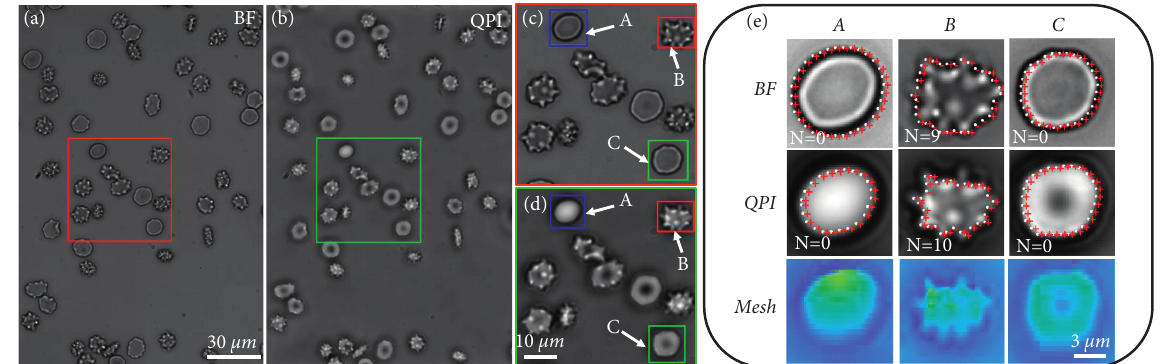
Figure 8: Morphological analysis of the different shapes of RBCs in BF and QPI. (a) RBC BF image. (b) RBC QPI image. (c) Local image as shown in the red box of (a). (d) Local image as shown in the green box of (b). (e) BCs of the three shapes of RBCs in BF and QPI and their mesh form, where the white dots of A, B, and C are the equally spaced sampling points of cell boundary, red marks “+” represents positive value of BC, red marks “ − ” represents the negative value of BC, and N is the number of negative values of BC mentioned in equation (4).